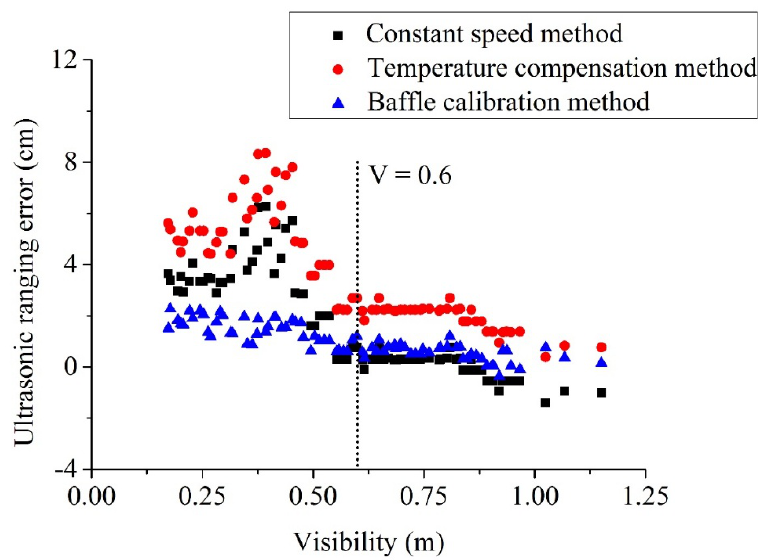
Figure 11. Measurement errors of three typical methods along the visibility, the measurement errors can be divided into two stages at a visibility of 0.6 m.